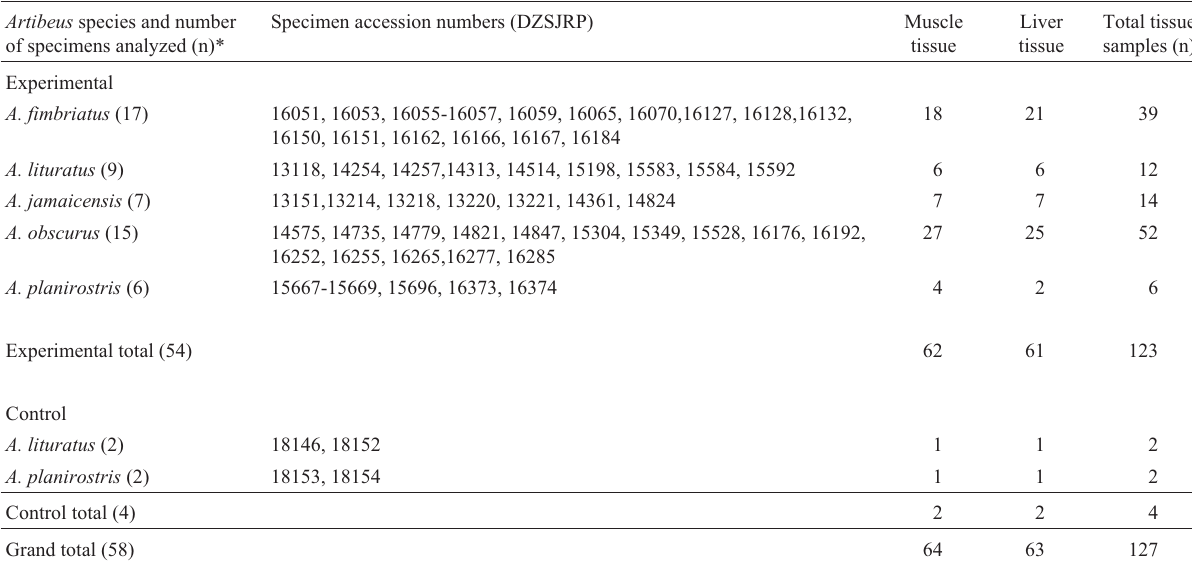
Table 1 - Number of preserved voucher specimens (n) of Artibeus frugivorous bats and liver and muscle samples analyzed. The experimental group tis- sues were formalin-fixed while the tissues in the control group were fresh-frozen.